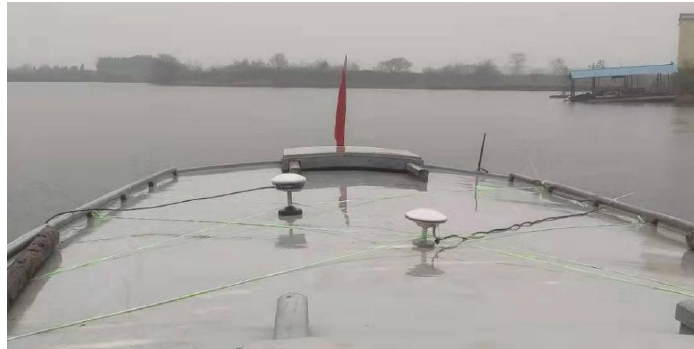
Figure 21. Installation position of GNSS antenna.